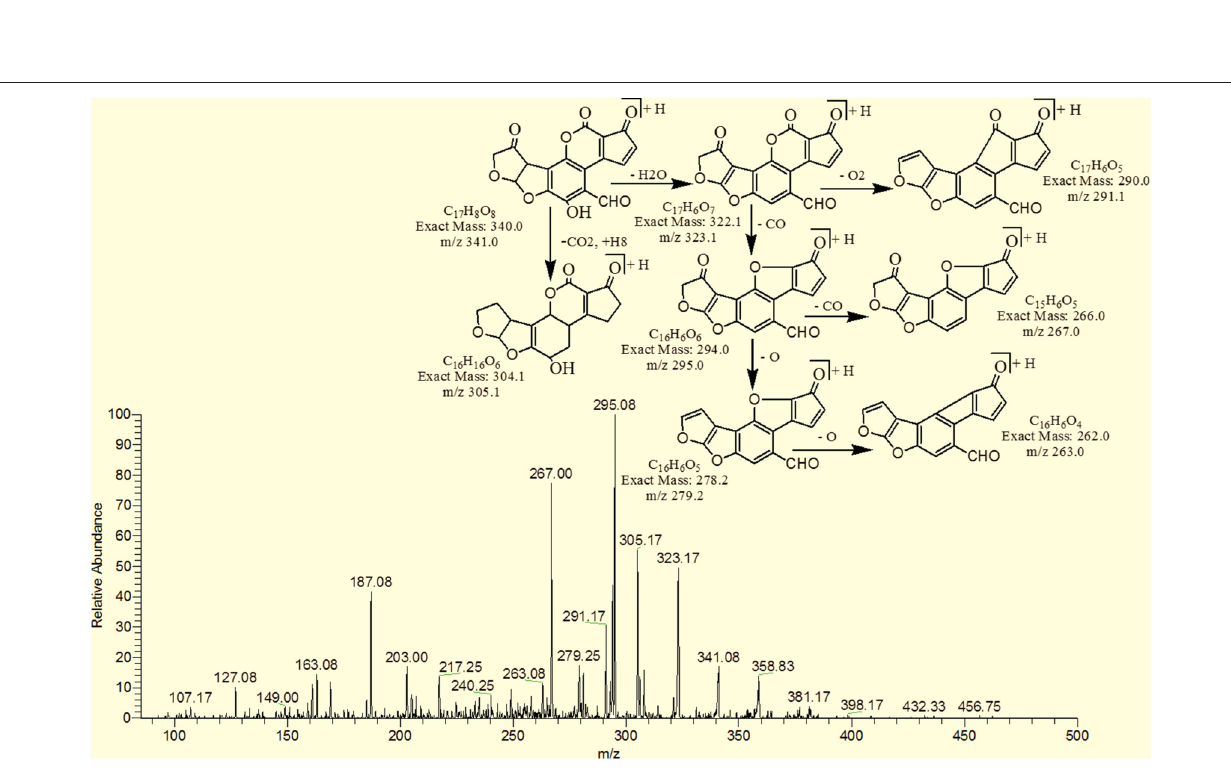
Frontiers in Microbiology |